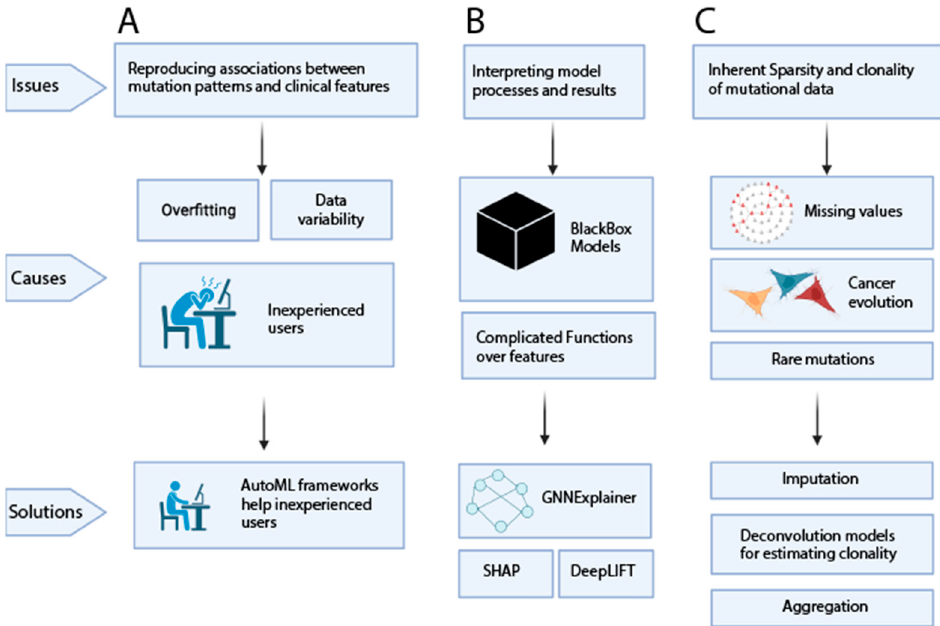
Figure 4. Key challenges for clinical integration of computationally derived mutational patterns and machine-learning methods that address these issues, including ( A ) reproducibility, ( B ) interpretability, and ( C ) inherent sparsity and clonality of the mutational